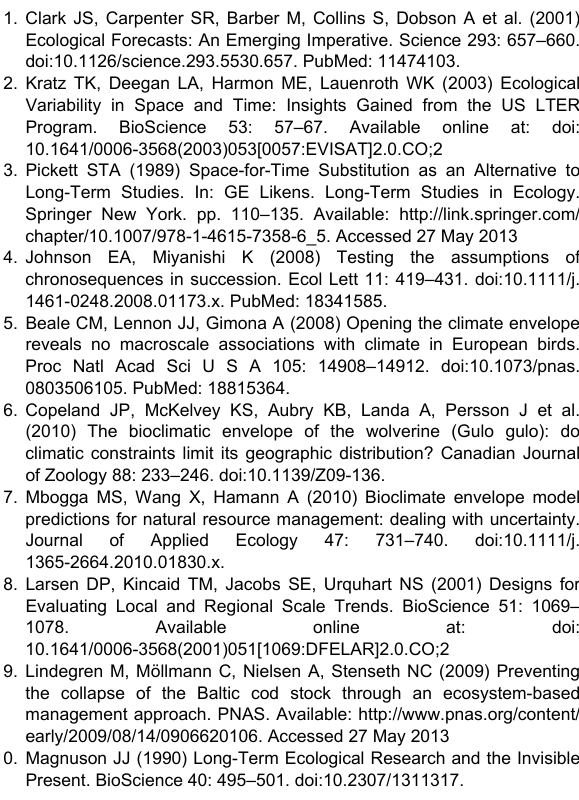
Table S2. Bias of non-contiguous models when predicting different spatial scales. Bins were created to examine bias at varying days since dry (0-250, 251-500, 501-750, and >1000). Numbers represent the number of bins that had a bias value > 5. As in table S1, in all cases where there were spikes in bias values, these occurred in bins that had the largest